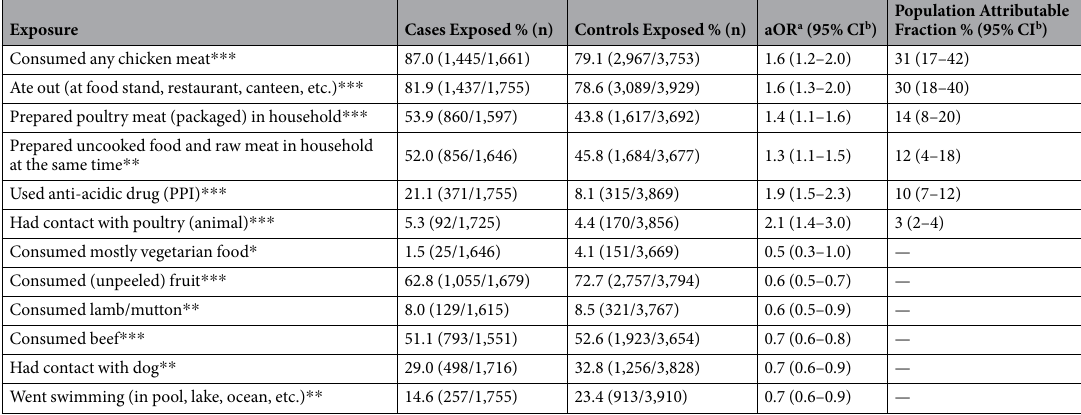
positively associated with Campylobacter infection (aOR 1.9; PAF 10%). We found a negative association with disease in the final model for a mostly vegetarian lifestyle (aOR 0.5); consumption of beef (aOR 0.7); consump- tion of lamb/mutton (aOR 0.6); consumption of fruit (aOR 0.6); contact with a dog (aOR 0.8); and recreational swimming (aOR 0.7) (Table 3). Results of multivariable analysis were similar when the model was restricted to C. jejuni infections, except that the association of contact with poultry animals and disease was no longer statistically significant (data not shown). In an analysis restricted to children under 5 years of age, contact with sand in a sandbox (PAF 39%), prepara- tion of poultry meat (fresh or packaged) in the household (PAF 38%), contact with poultry animals (PAF 22%), and a migrant background (PAF 10%) were positively associated with a Campylobacter infection. Consumption of chicken meat was not a statistically significant risk factor for this age group. No exposure variables were negatively associated with disease in this analysis (Table 4). In an analysis to identify risk factors for C. coli infections, consumption of pork (PAF 66%) and the use of gas- tric acid inhibitors in the past 4 weeks (PAF 20%) were positively associated with disease, whereas consumption of beef and consumption of fruit were negatively associated (Table 5). When we performed the same multivariable analysis including cases and controls that had travelled abroad and with an additional exposure variable “travelled abroad”, the results did not change substantially. Travelling abroad was positively associated with Campylobacter infection in the model for all age groups ( P < 0.001; Supplementary Table S1), and in the models for C. jejuni ( P < 0.001) and C. coli infections ( P < 0.05). Travelling abroad was not statistically significantly associated with Campylobacter infection in the model for children < 5 years of age (data not shown). We also performed multivariable logistic regression analysis with cases whose Campylobacter isolate had been attributed to the source chicken with a probability of 50% or higher in the source attribution model (n = 486) and the controls (n = 3,983). Risk factors and strengths of associations were similar to the model with all 1,812 cases: consumption of chicken meat (aOR 1.9); eating out (aOR 1.4); preparation of packaged poultry meat in the household (aOR 1.6); simultaneous preparation of raw meat and food items consumed uncooked (aOR 1.4); use of gastric acid inhibitors (aOR 1.8). In the final model, contact with poultry animals and having gone swimming were not statistically significantly associated with Campylobacter infections attributed to chicken (Supplementary Table S2). Compared to the model with all cases (Table 3), population attributable fractions calculated for con- sumption of chicken meat (41% vs. 30%), preparation of poultry meat in the household (21% vs. 14%) and simul- taneously preparing uncooked food and raw meat in the household (17% vs. 12%) were higher, whereas the PAF for eating out was lower (25% vs. 30%), and the PAF for use of gastric acid inhibitors was about the same (11% vs. 10%) (Supplementary Table S2). Due to the small number of human isolates that were attributed to sources other than chicken considered in our source attribution model (pigs, pets, cattle, poultry other than chicken), multivariable analyses similar to the ones we performed for chicken could not be conducted. In univariable analyses (not adjusted for age group, sex, federal state) we found statistically significant associations of Campylobacter infections attributed to pig (n = 24) and consumption of pork (100% of cases (with complete answers) had consumed pork (23/23; OR could not be calculated) vs. 85% of controls (3,220/3,787); P < 0.001), but not a statistically significant association with consumption of chicken (OR 0.95; P = 1.0). The majority of case patients with isolates assigned to the source pig reported both consumption of pork and chicken (77%; 17/22). None of the case patients with Campylobacter iso- lates assigned to the source pet (dog or cat; n = 10) reported contact with a dog (versus 33% of controls) and 3/10 reported contact with a cat (versus 33% of controls; OR 0.9; P = 1.0).